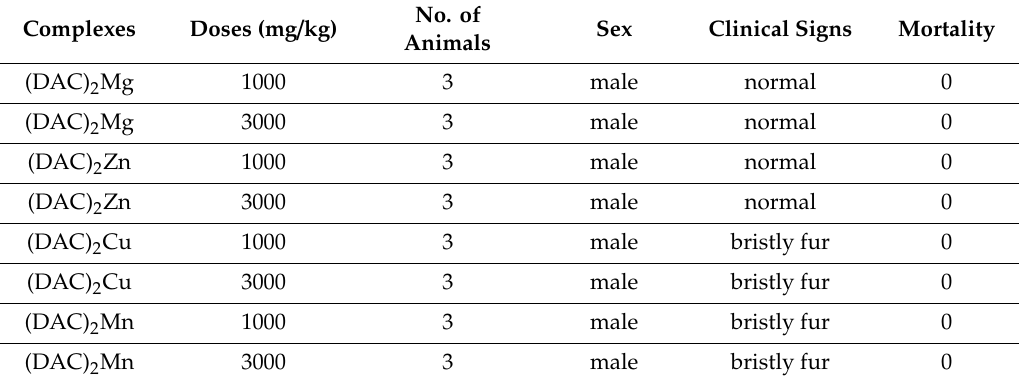
Table 11. Clinical signs and mortality of mice receiving acute oral